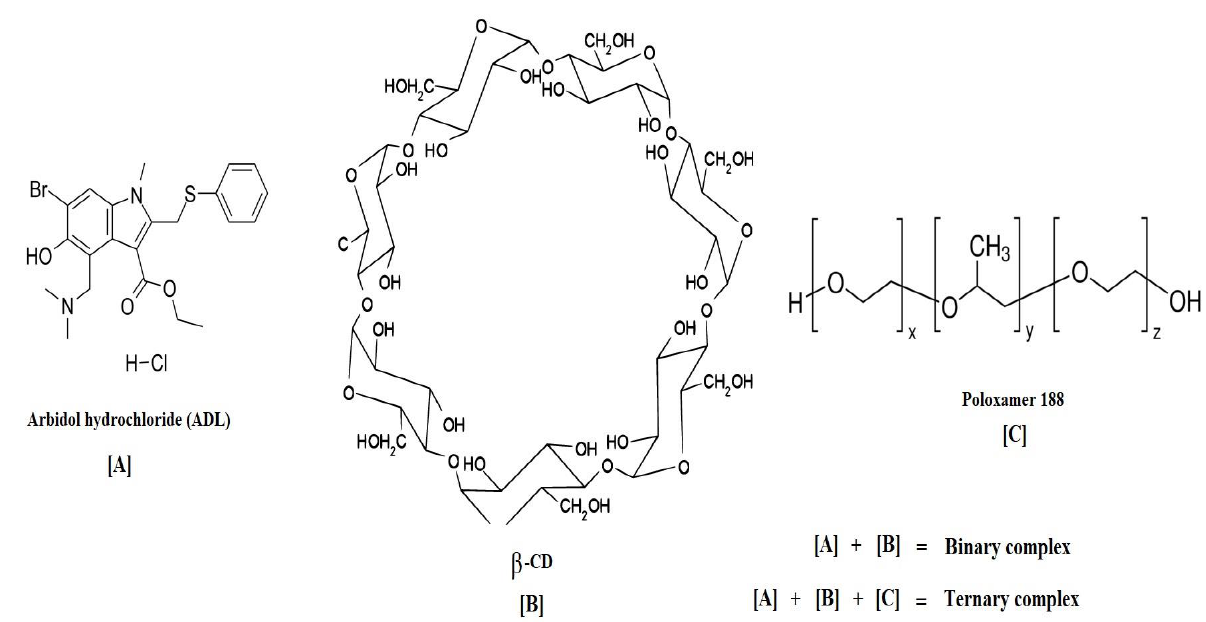
Figure 10. Chemical structure of arbidol hydrochloride, β -cyclodextrin and poloxamer 188.